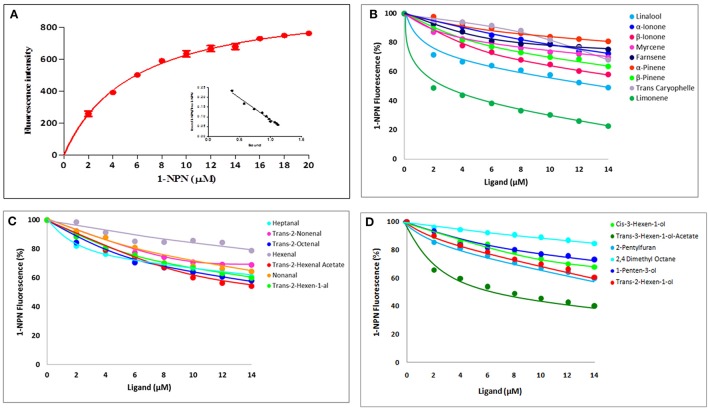
Competitive Binding of 1-NPN and corn odorants to McinOBP4. (A) Binding curves and relative Scatchard plot (insert) of 1-NPN and McinOBP4 protein. (B) Competitive binding affinities of McinOBP4-Wt to different terpenoids corn odorants. (C) Binding affinities of various aldehyde odorants to McinOBP4-Wt and (D) Affinities of McinOBP4-Wt to aliphatic alcohol and others.